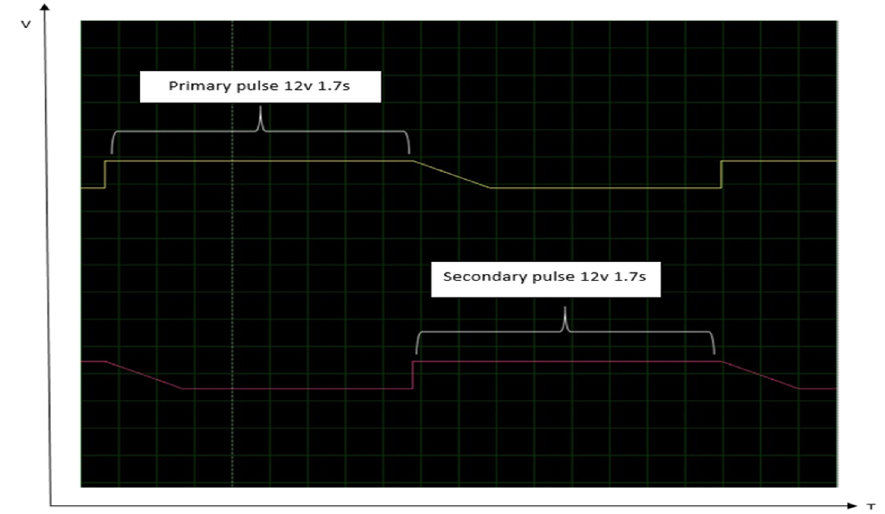
Figure 11. Test reading for electric brake pulse on a 12 v scale per square and 2 s.